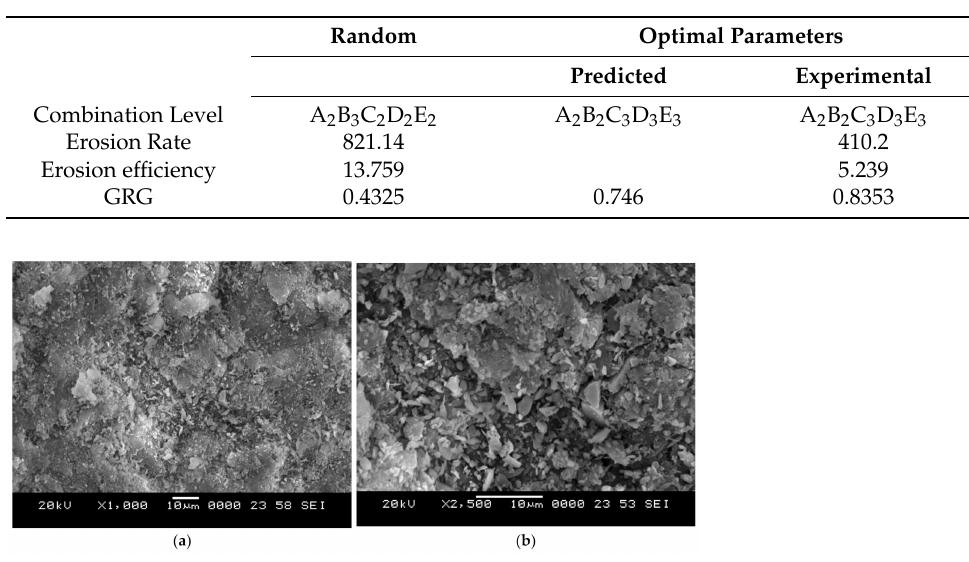
Figure 5. Scanning electron micrograph of the sample tested for A 2 B 2 C 3 D 3 E 3 condition at ( a ) lower and ( b ) higher